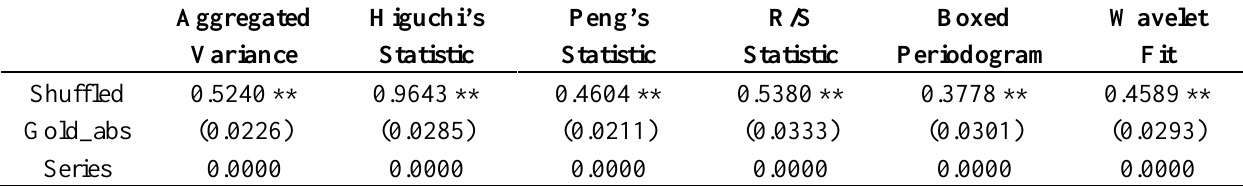
Table 7. Robustness analysis of the scaling exponent H models.